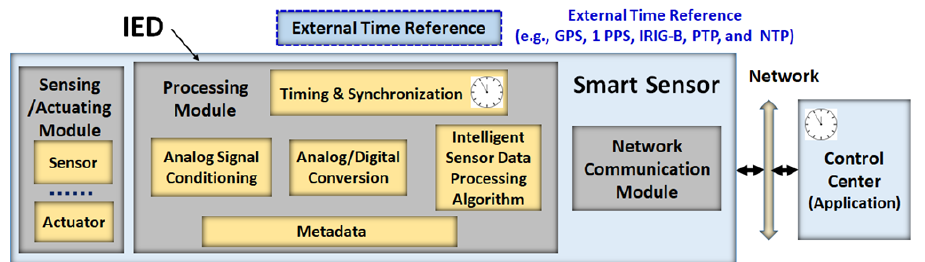
Figure 2. Representation of functional elements of smart sensor systems. Image credit: reprinted from working document for P2681 based on Figure 2 of IEEE Sensors Journal paper [17]. Copyright IEEE 2017. All rights